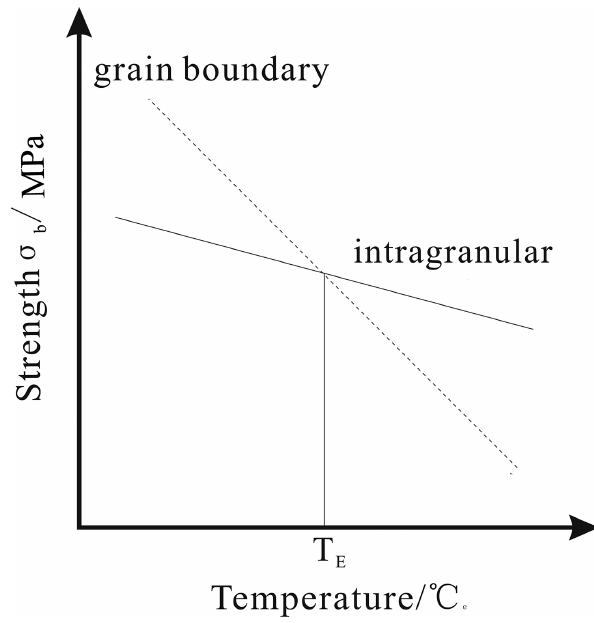
Figure 4: Schematic of the strength of grain boundary and intra- granular of alloys as a function of temperature.